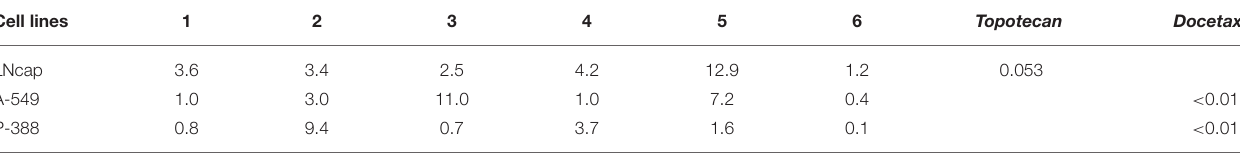
TABLE 4 | Cytotoxic activity (IC50, mM) of compounds 1–6. Cell